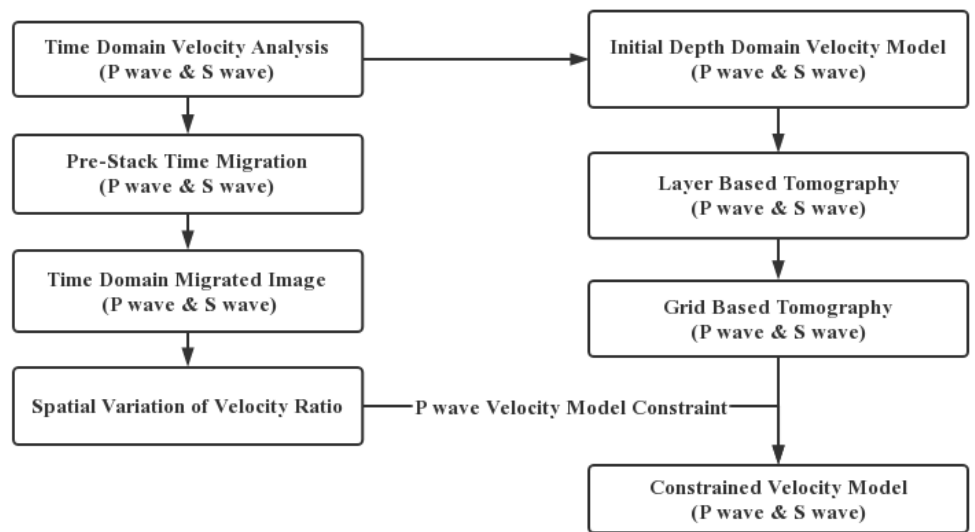
Figure 8. V S /V P ratio in the survey.